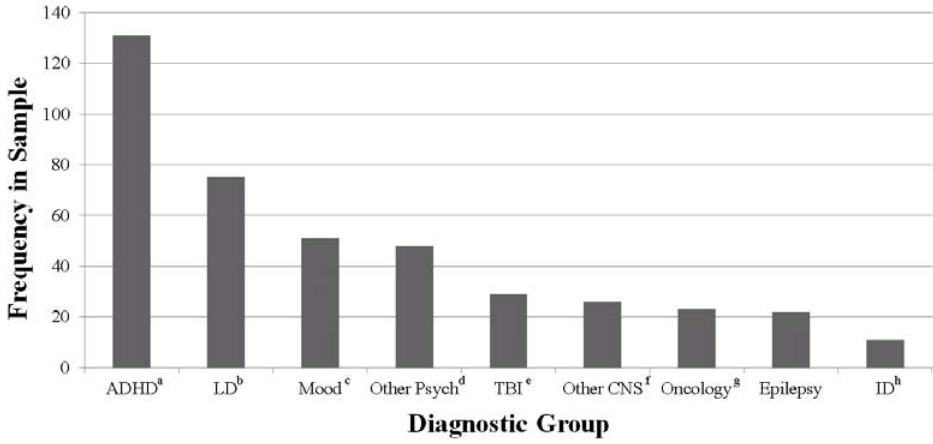
Figure 1. Psychiatric disorders and medical/neurological conditions represented in the study sample. a Attention-Deficit/Hyperactivity Disorder; b learning disabilities; c mood disorders (e.g., major depression, generalized anxiety disorder); d other psychiatric disorders (e.g., conduct disorder, impulse control disorder); e traumatic brain injury; f other central nervous system disorders (e.g., apraxia, sleep disorders); g oncology (e.g., brain tumor, acute lymphoblastic leukemia); h intellectual